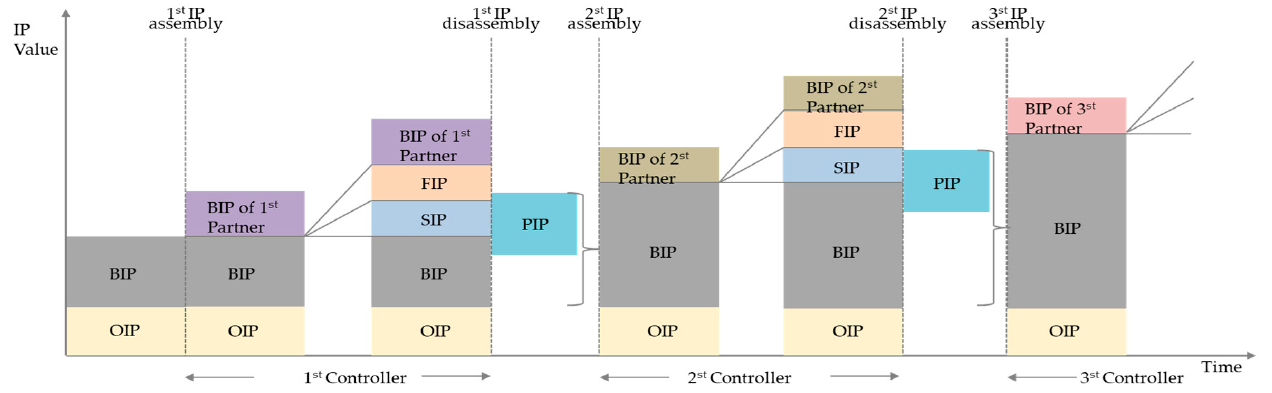
Figure 3. Systematic securing of BIP (Revised).